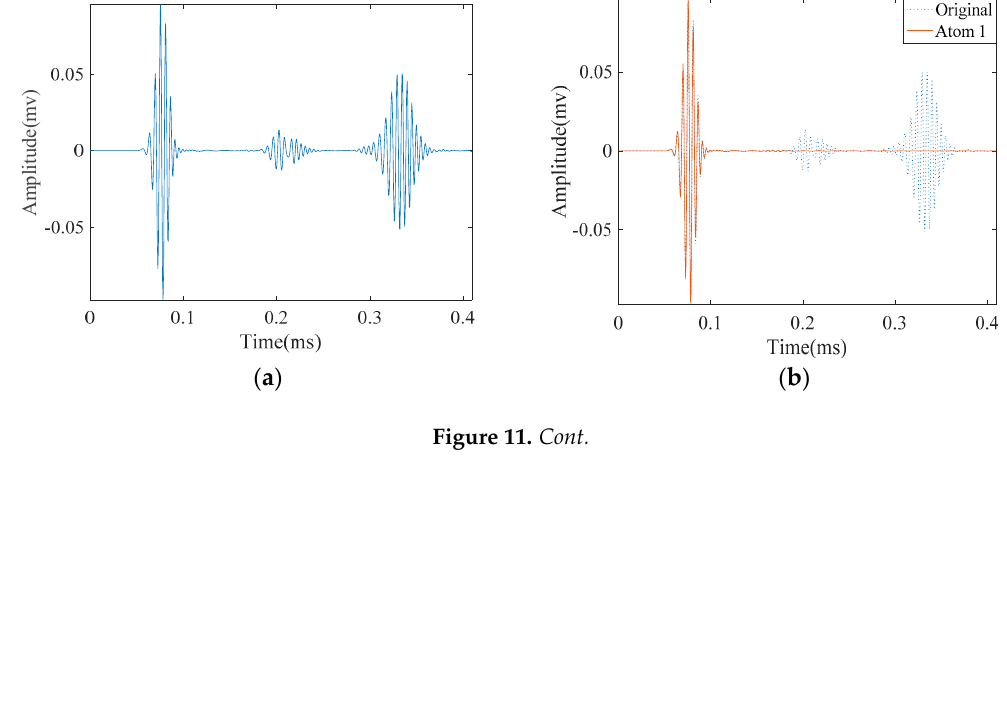
Figure 10. Detection of small defect in the presence of noise with different SNRs with MP: ( a ) the original signal; ( b ) approximation of crack reflected signal without noise; and ( c ) with added noise SNR = 23.8 dB; and ( d ) with added noise SNR = 9.8 dB.